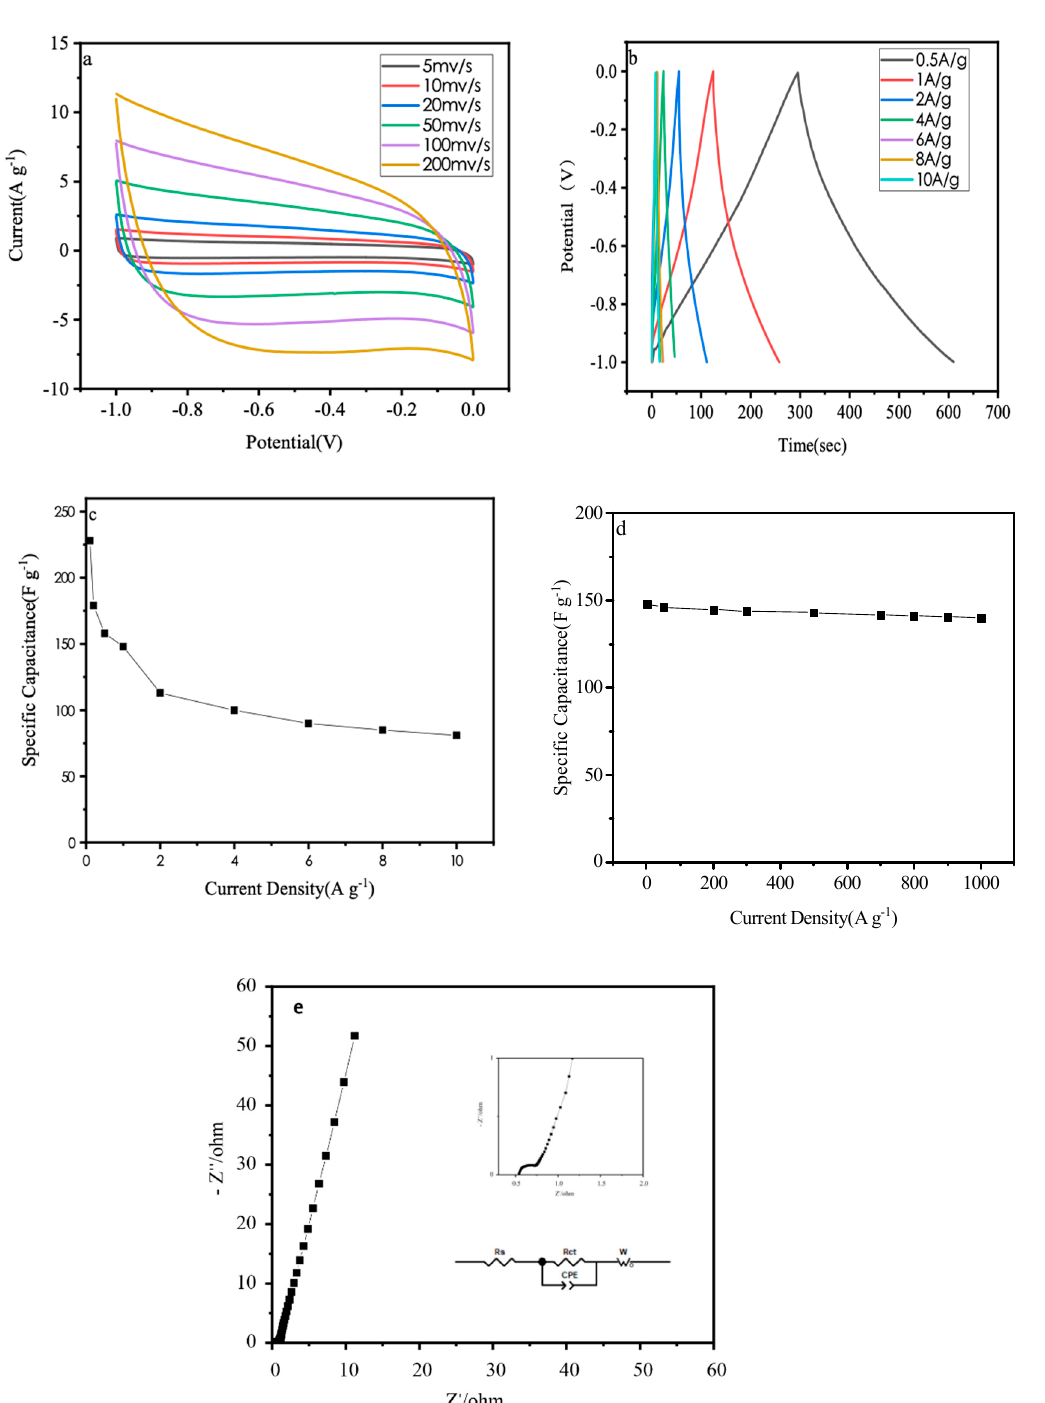
Figure 5. ( a ) cyclic voltammetry (CV) curves of porous carbon at various scan rates; ( b ) galvanostatic charge / discharge curves of porous carbon under various current densities; ( c ) specific capacitance versus current density of porous carbon; ( d ) cycling stability of porous carbon at 1A / g; ( e ) Nyquist plots. Figure 5b is a galvanostatic charge / discharge curve with di ff erent current densities. The curve approximates an isosceles triangle. Because it shows excellent reversible and charge / discharge performance, this porous carbon can be used as electrode material for a supercapacitor. When the current density is 0.5, 1.0, 2.0, 6.0, 8.0 and 10.0 A / g, the specific capacitance is 159, 148, 113, 90, 85